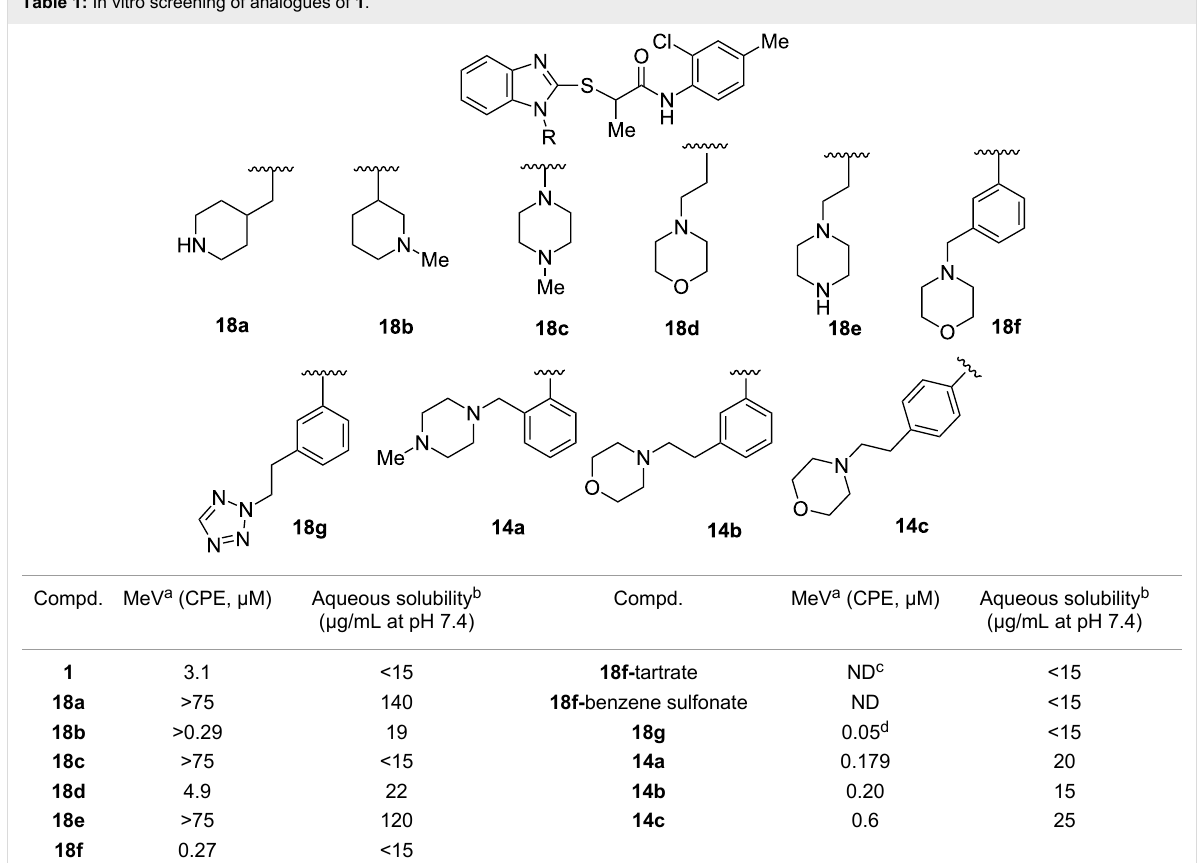
Table 1: In vitro screening of analogues of 1 .